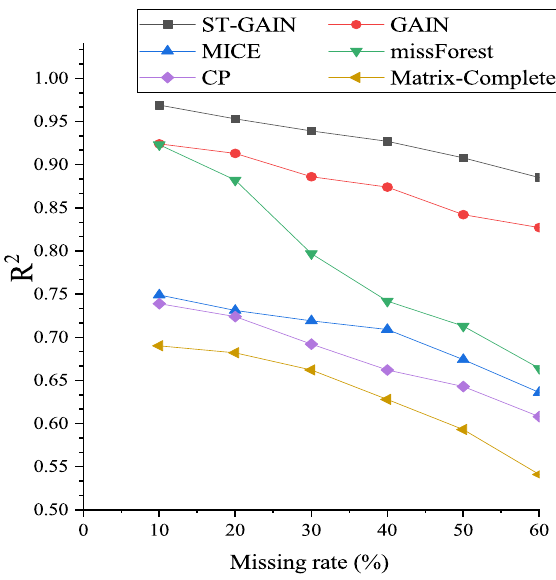
Figure 11. R 2 for different miss